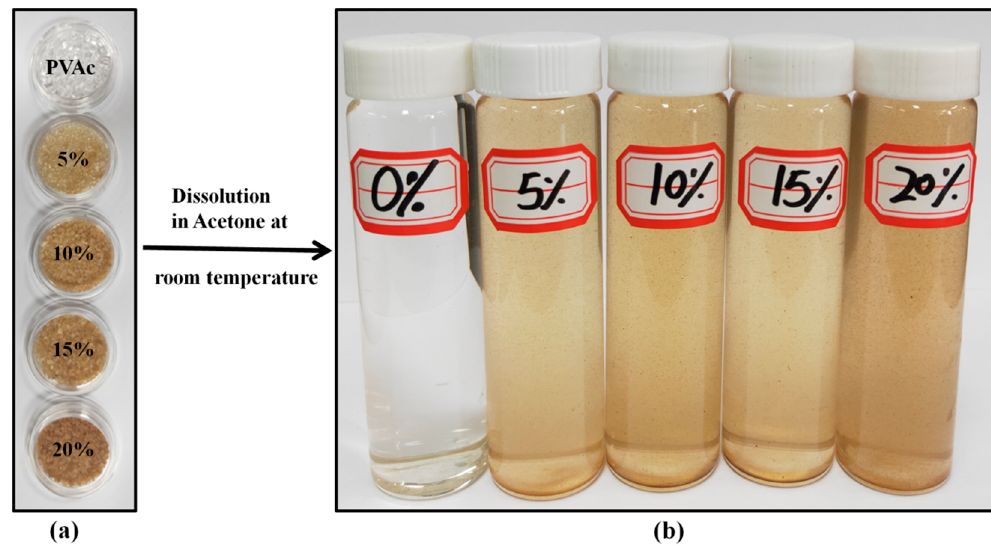
Figure 1. Pictures of ( a ) the prepared copolymers containing different fractions of lignin, and ( b ) the coating solutions of polyvinyl acetate (PVAc) and its copolymers.